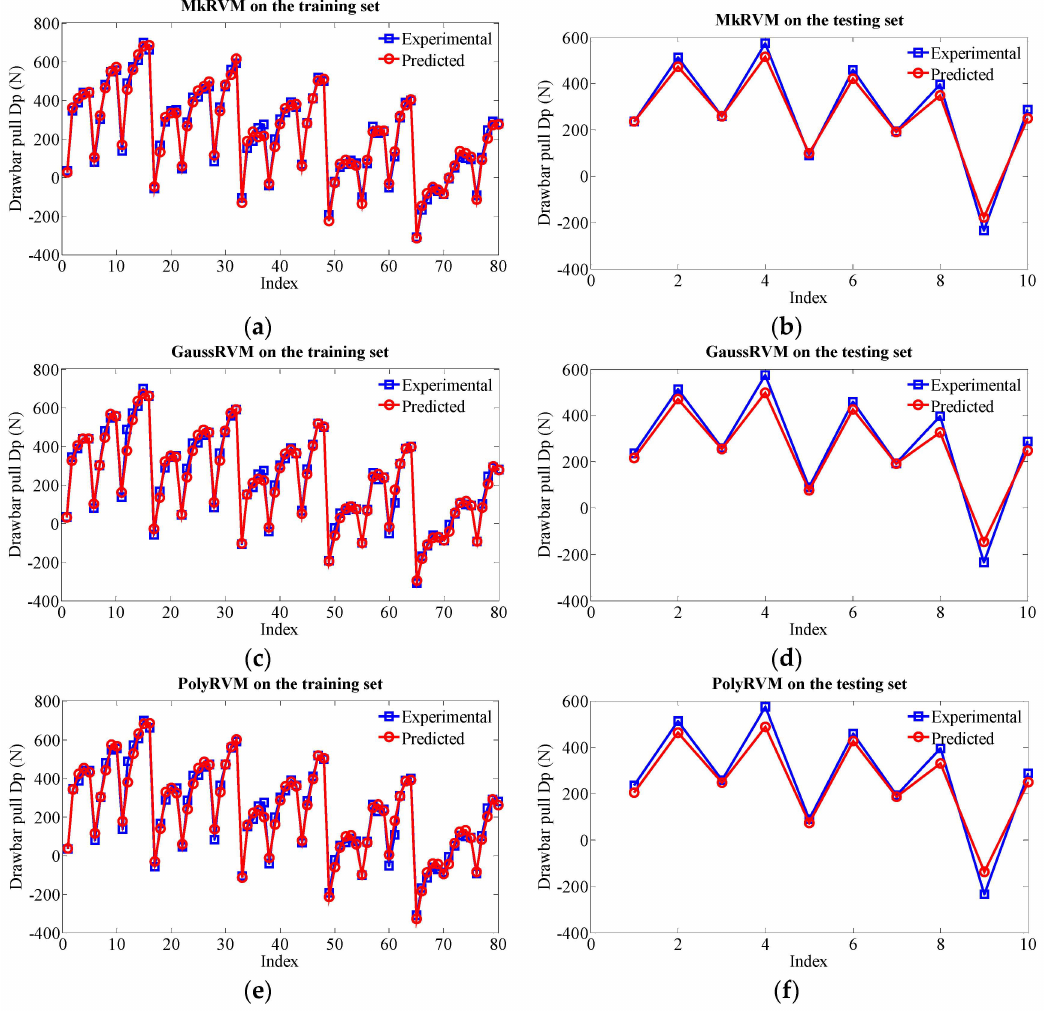
Figure 11. Prediction results of the three RVM model with three kernel functions on the training set and the testing set. ( a ) MkRVM on the training set; ( b ) MkRVM on the testing set; ( c ) GaussRVM on the training set; ( d ) GaussRVM on the testing set; ( e ) PolyRVM on the training set; ( f ) PolyRVM on the testing